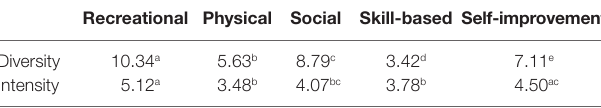
TaBle 4 | Diversity sum and intensity mean score by activity